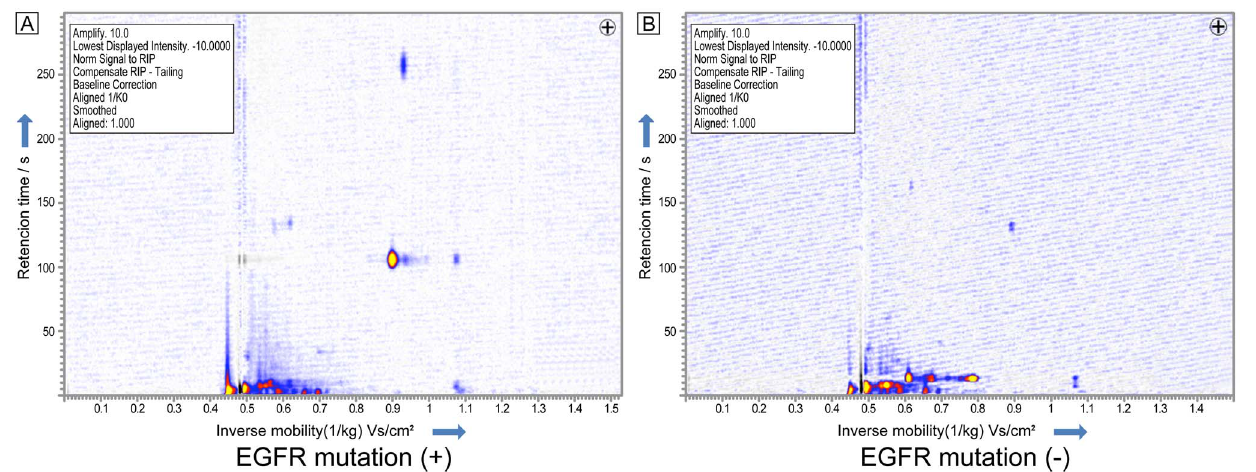
Fig. 5. IMS chromatogram in patients with lung adenocarcinoma positive for EGFR mutation (A) and negative for EGFR mutation